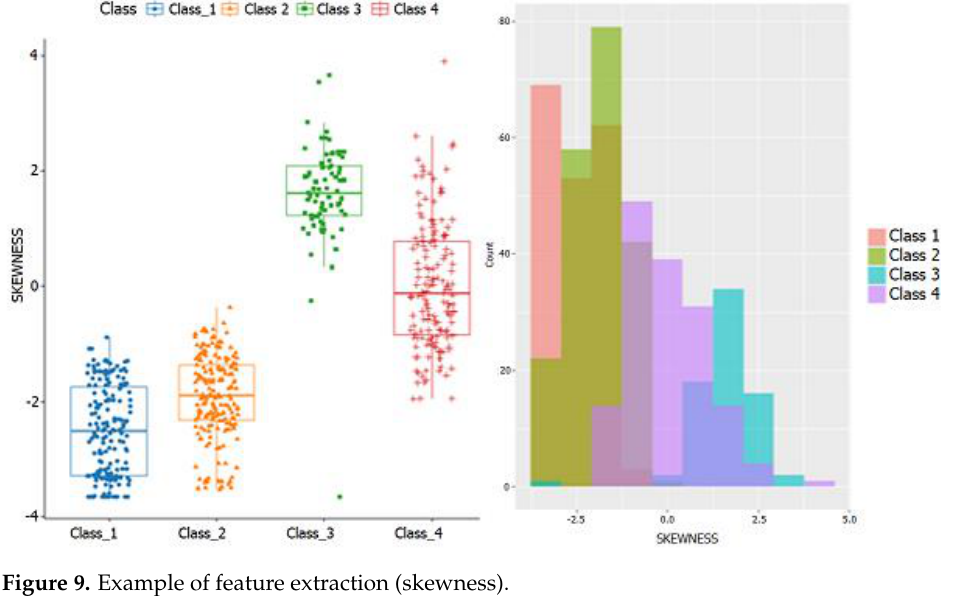
Figure 9. Example of feature extraction (skewness).